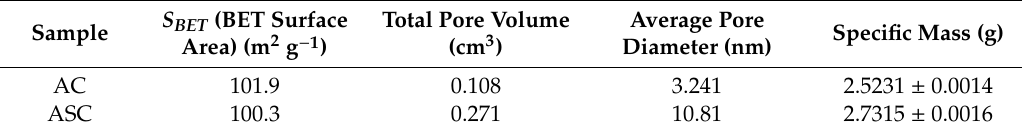
Table 1. Textural characteristics of activated carbon (AC) and activated carbon originated from sludge paste